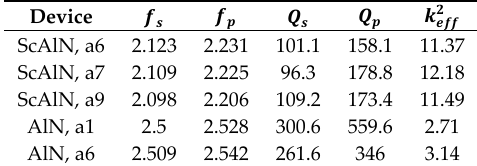
Table 1. SMR device parameters of both ScAlN and AlN-based resonators.